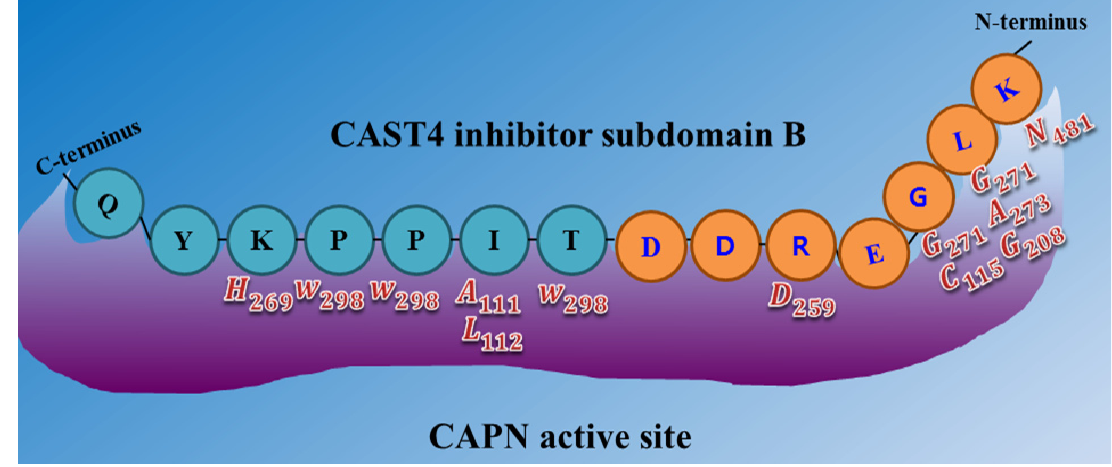
Figure 9. Schematic representation of the CAST4 subdomain B binding to the CAPN active site cleft both from bovines. The fragment N -terminal portion is built up of two α -helices and an extended β -strand, which interacts with a surface-localized binding loop of the enzyme. The C -terminal segment binds the two enzyme domains being anchored by a short α -helix (after Schechter and Berger nomenclature [24]).